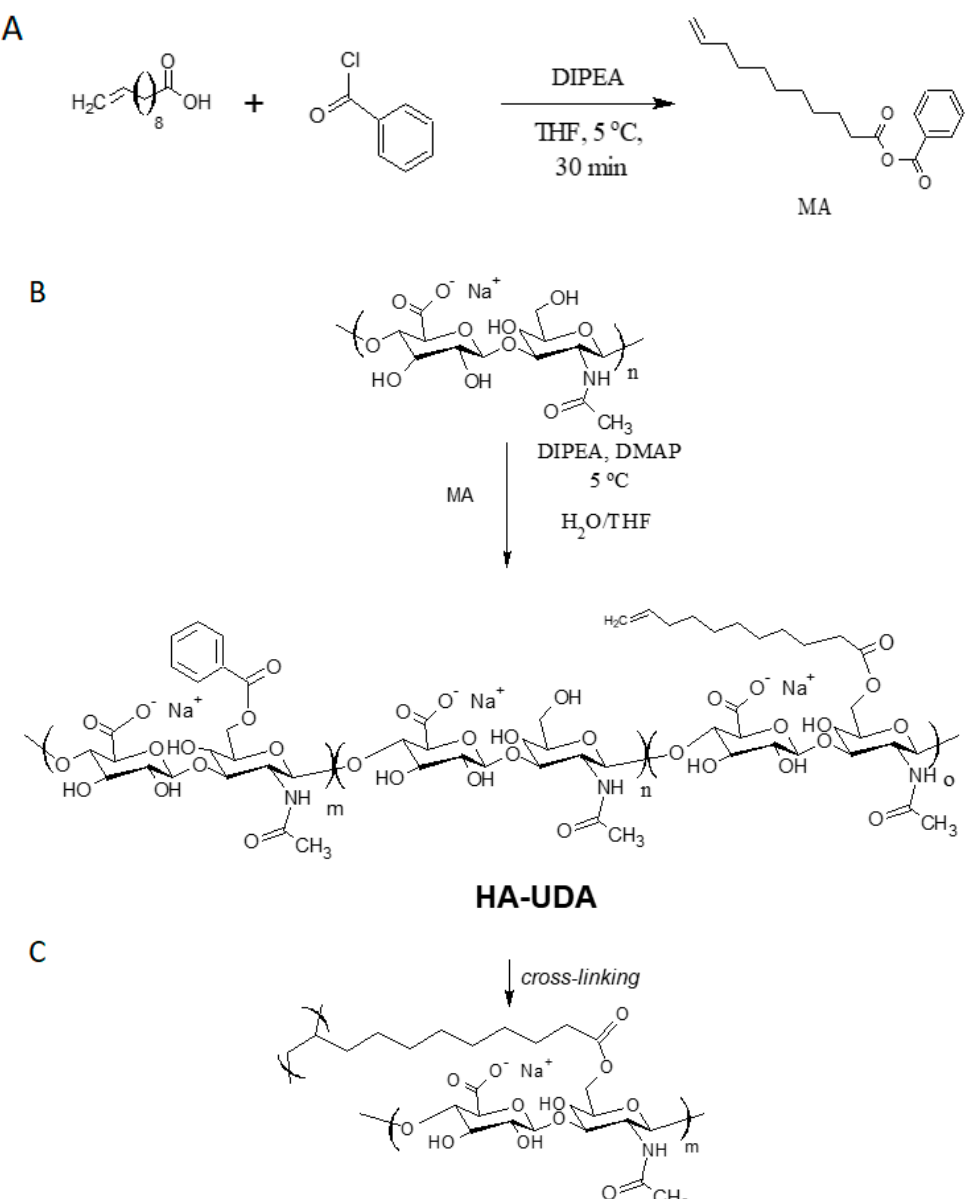
Figure 1. ( A ) The activation of 10-undecenoic acid was mediated by benzoyl chloride and formed the mixed anhydride (MA) ( B ) The acylation of hyaluronic acid was catalyzed by dimethylamine pyridine, and ( C ) denotes the chemical crosslinking of HA-UDA.